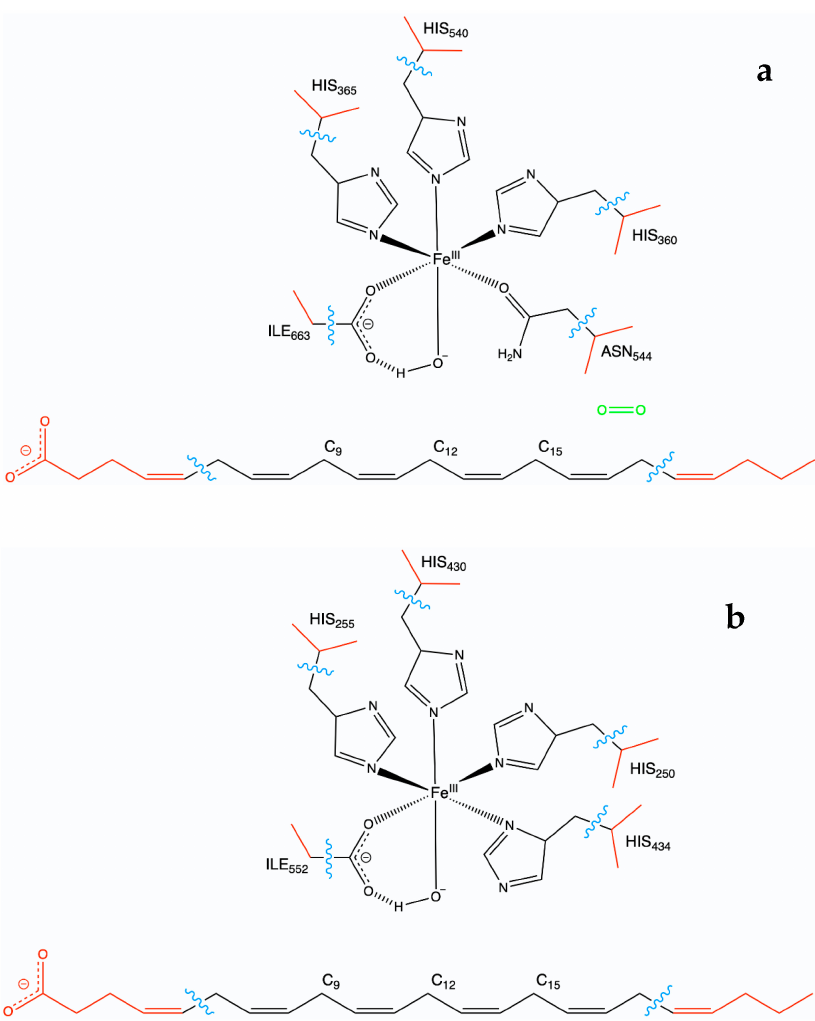
Figure 21. QM/MM partition in the DHA/hALOX12 ( a ) and DHA/pigALOX15-mini-LOX systems ( b